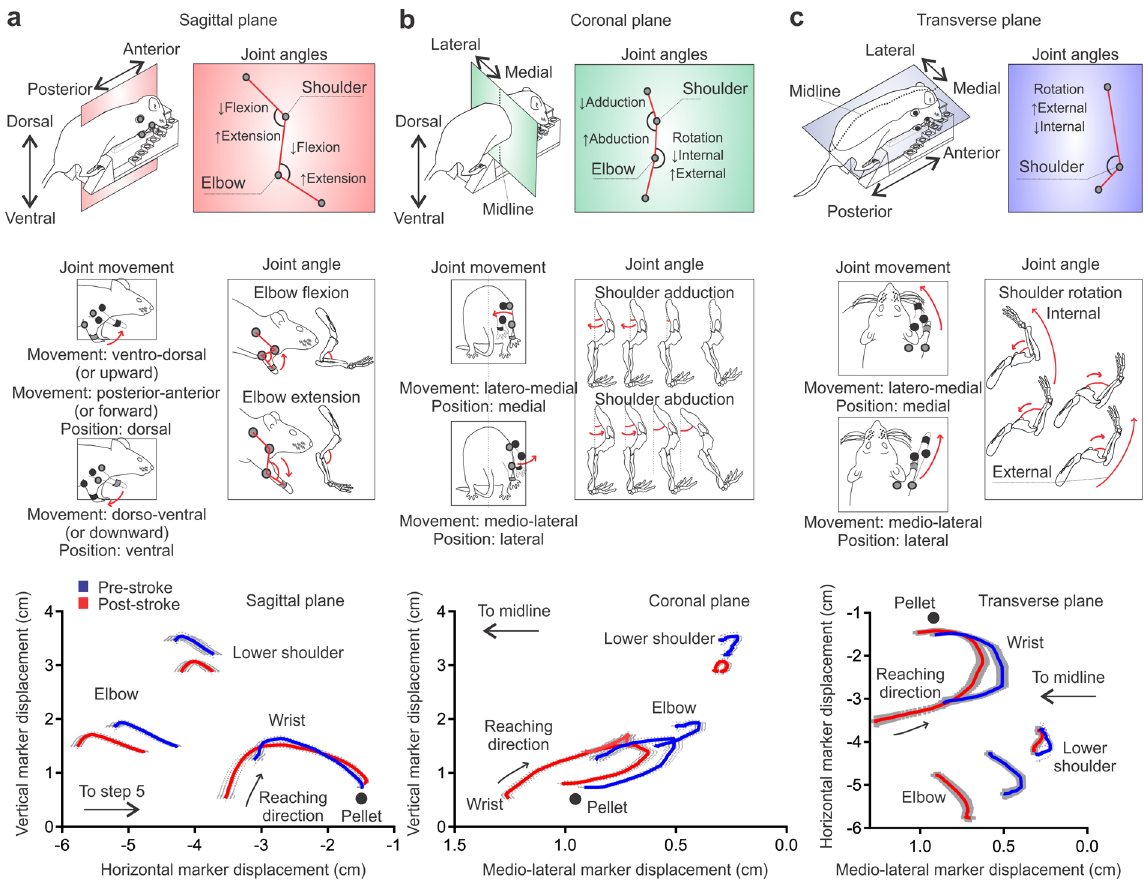
Figure 3. Summary of terminology for joint movements and angles. ( a ) Joint movement in the sagittal plane is ventro-dorsal (upward), dorso-ventral (downward), posterior-anterior (forward) and anterior-posterior (backward). The angular motion of the elbow and shoulder joints in the sagittal plane is flexion or extension. ( b ) Joint movement in the coronal plane is latero-medial or medio-lateral. The angular motion of the shoulder joint in the coronal plane is abduction or adduction. ( c ) Joint movement in the transverse plane is latero-medial or medio-lateral. The angular motion of the shoulder joint in the coronal plane is external or internal rotation, and is measured using elbow joint angle (see methods). Bottom panels of ( a – c ) show the marker displacement of the wrist, elbow and shoulder joints in the sagittal, coronal, and transverse planes, respectively. Mean ± s.e.m. traces (n =